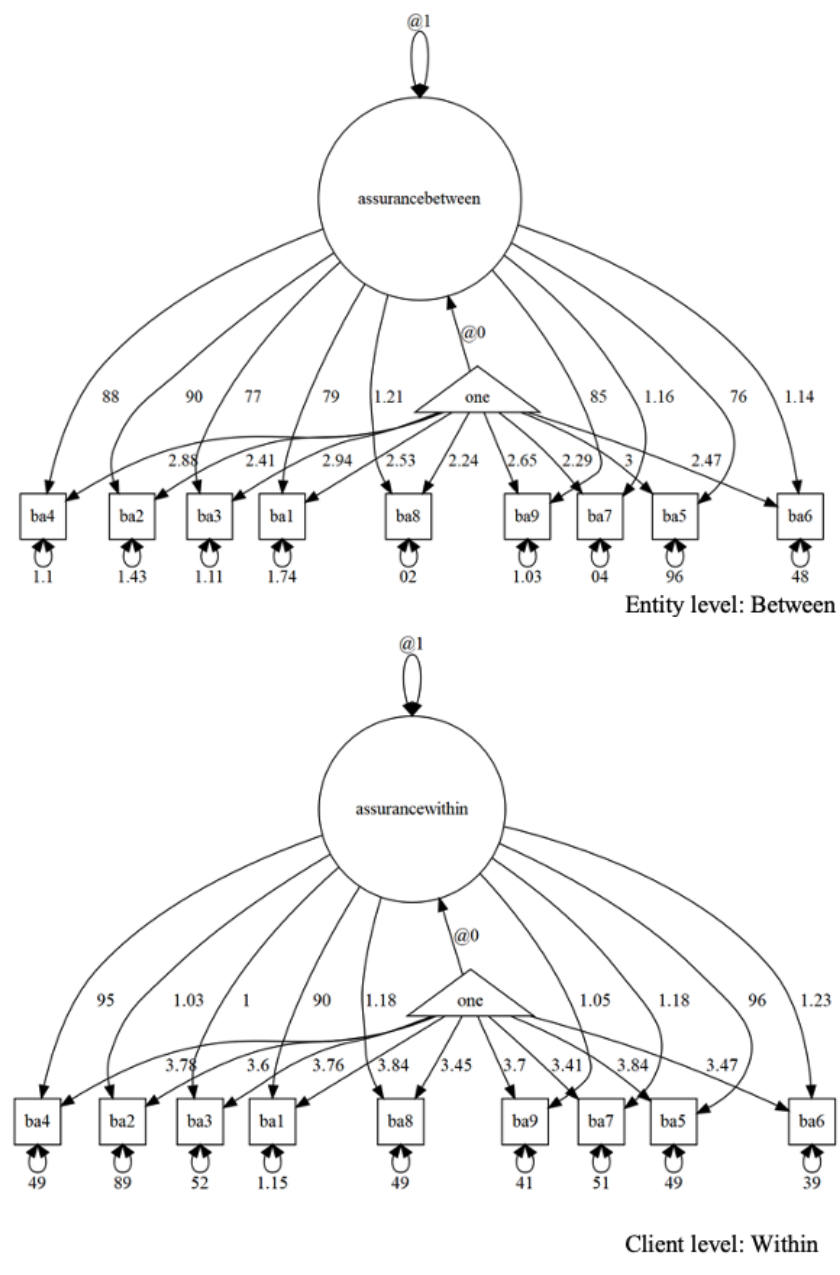
Figure 1: Path diagram showing the measurement of